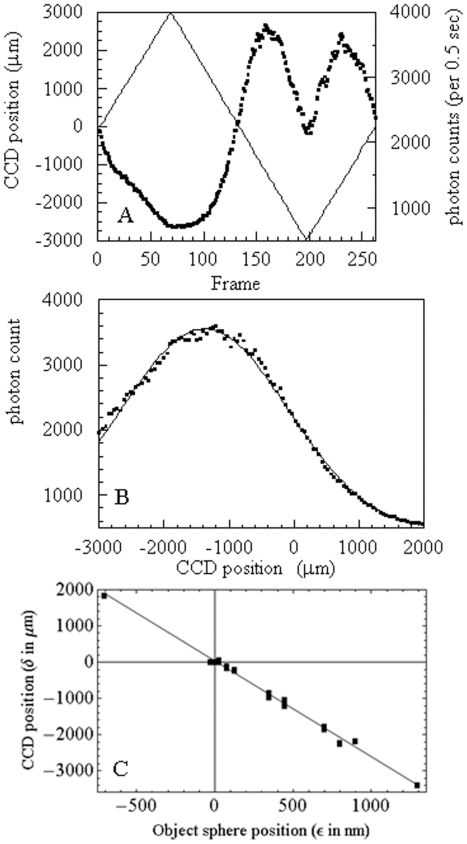
A translating CCD camera records the axial PSF to calibrate axial image space.Panel A shows the camera position saw-tooth pattern (solid line) and the fluorescence intensity observed from the point source (▪). The left hand side abscissa scale applies to the saw-tooth curve. The right hand side abscissa scale applies to intensity (▪). Intensity is the sum of photons in 2×2 or 3×3 pixel regions defining the focused point source. Panel B is the camera axial position (independent variable) vs fluorescence intensity (dependent variable) including only the middle portion of the saw-tooth pattern where camera position changes monotonically. The fitted curve is the PSF computed as described in RESULTS. Panel C shows the calibration curve indicating the relationship between δ and ε in Figure 2. The slope of the curve is the axial magnification, Ma.